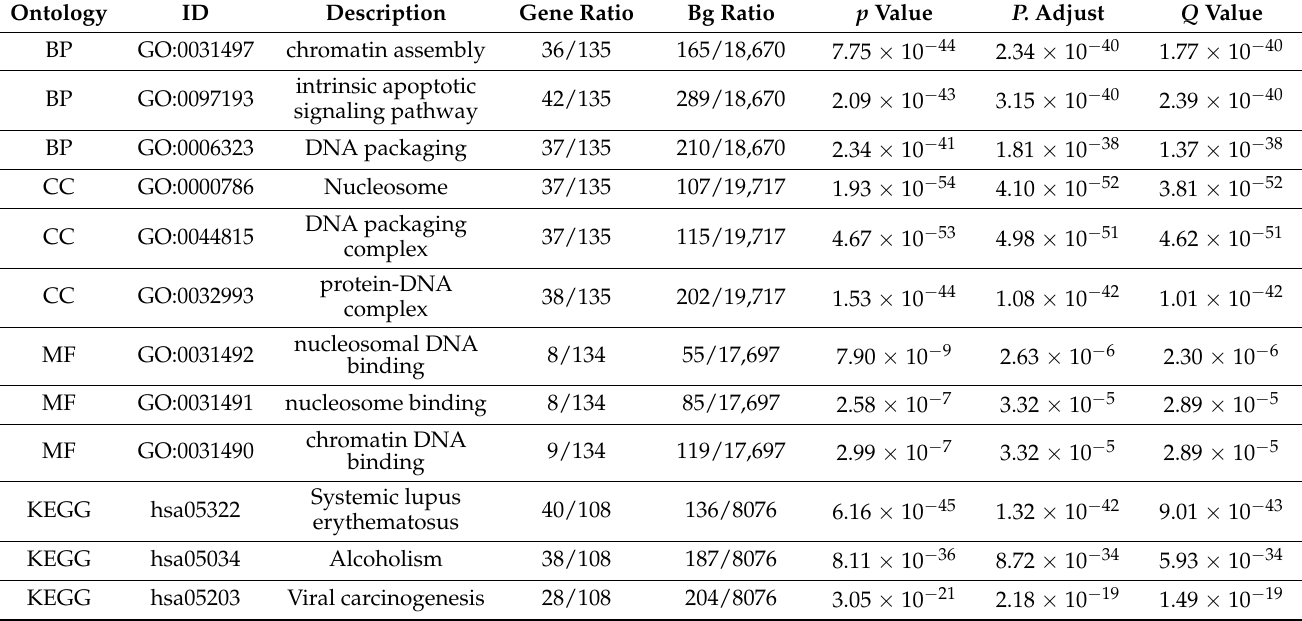
Figure 2. Functions and mechanisms of oxidative stress-related DEGs using GO and KEGG analysis: ( A ) biological process; ( B ) cell composition; ( C ) molecular function; ( D ) signaling pathways. ( E ) interaction between functions and mechanisms. Note: DEGs: differentially expressed genes; BP: biological process; CC: cell composition; MF: molecular function; GO: Gene Ontology; KEGG: Kyoto Encyclopedia of Genes and Genomes. Table 1. GO enrichment and KEGG analysis of 135 differentially expressed OSRGs.